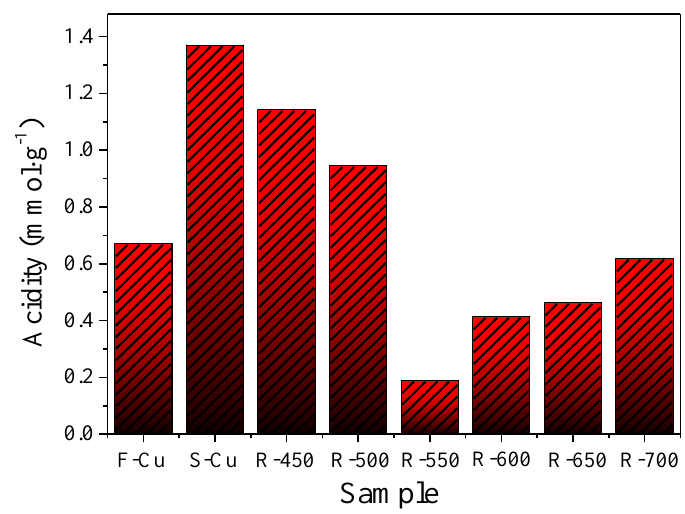
Figure 9. The acidity of Cu-SSZ-13 catalysts in fresh, sulfated and regenerated state.